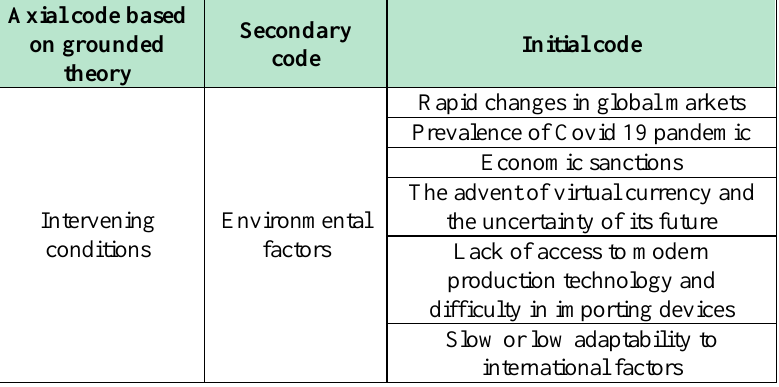
Table 5: Open coding of qualitative data (Intervening conditions) Axial code